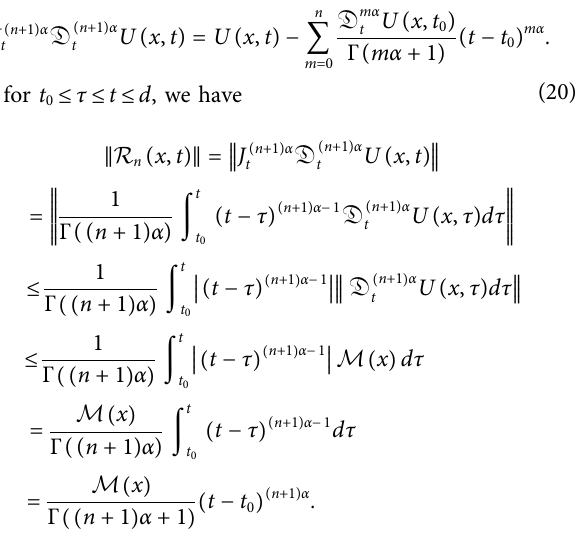
TABLE 1 | Values of || RES